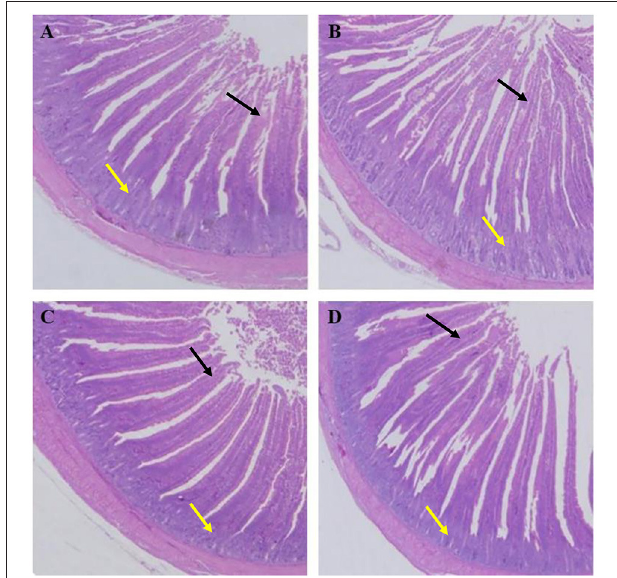
FIGURE 3 | Dietary plectasin increased the duodenum length while decreased crype depth of 21-day-old yellow-feathered chickens. (A) The duodenum of basal diet group, (B) The duodenum of basal diet plus 10mg enramycin/kg, (C) The duodenum of basal diet plus 100 mg/kg plectasin, (D) The duodenum of basal diet plus 200 mg/kg plectasin. Black arrow shows the villus length, and yellow arrow shows the crypt depth. For histological observation, image at 40 were